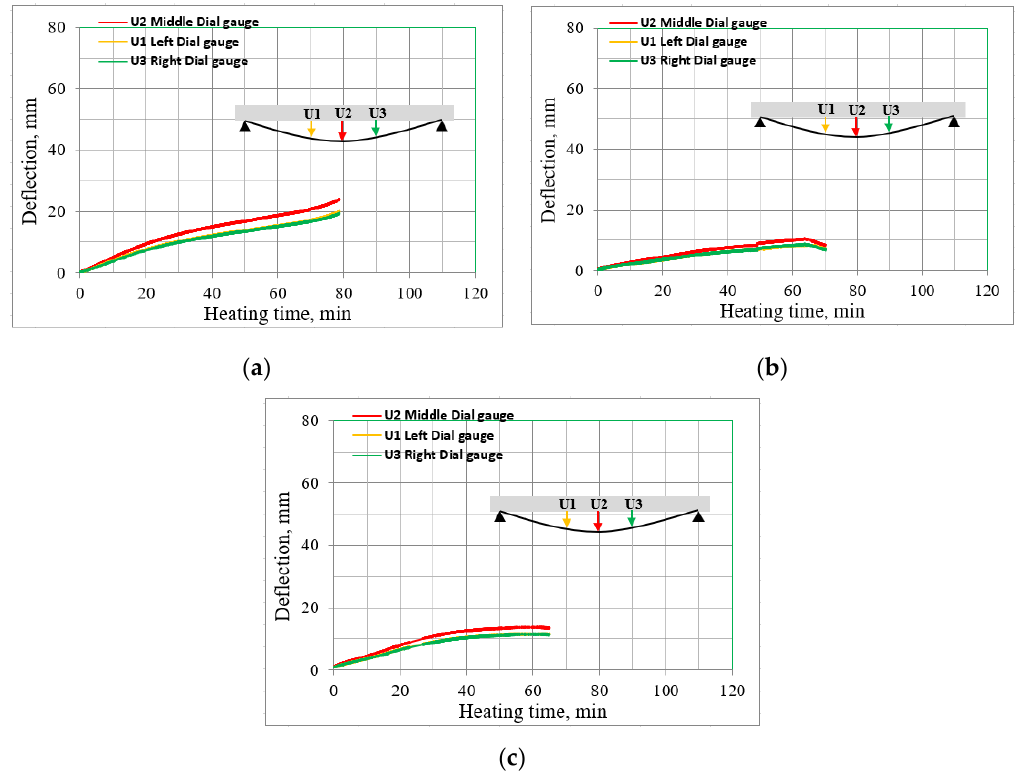
Figure 8. Mid-span deflections during the heating phase; ( a ) B2Ø14, ( b ) H2Ø14, ( c ) N2Ø14.